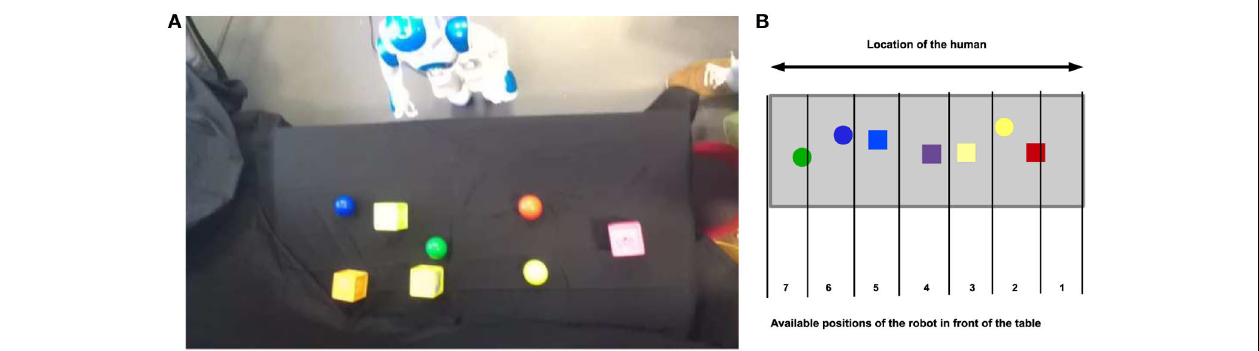
FIGURE 1 | Experimental setup used with the Nao robot. Colorful objects are placed on a table covered with a black cloth to facilitate the extraction of the contours of the objects. The robot can then step laterally to change the view of the scene, and the perceptual inputs to be learned. These steps move the robot incrementally from one index position to the